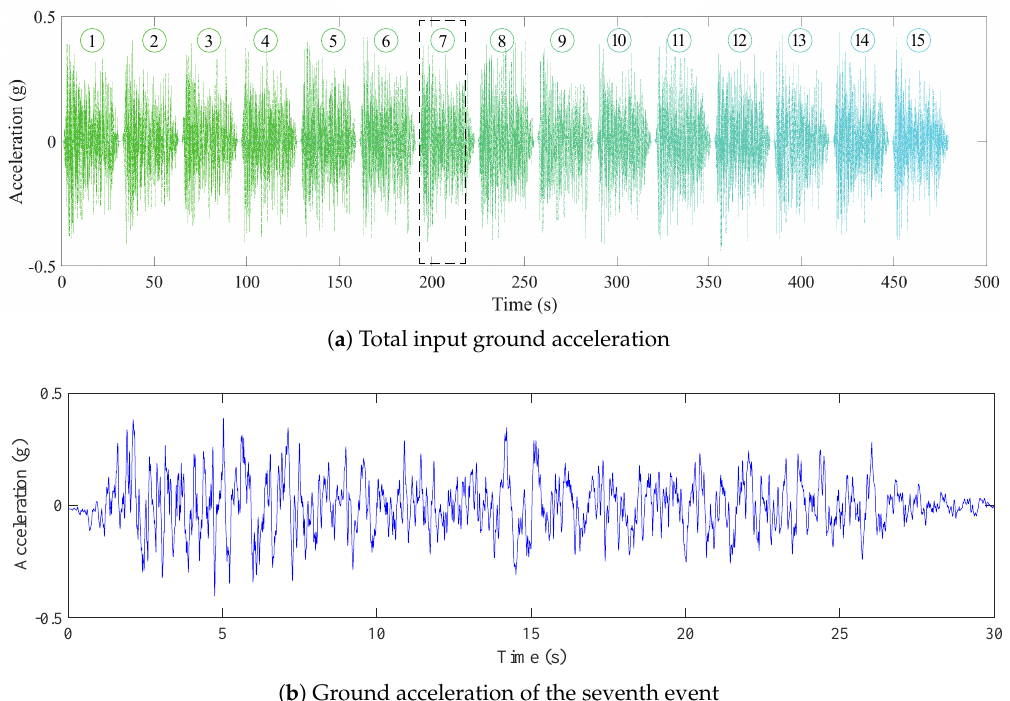
Figure 8. Input ground acceleration of the design